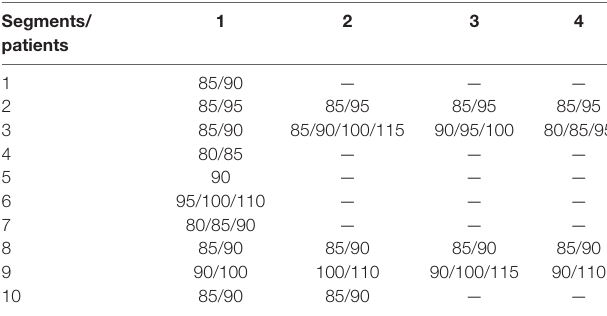
TABLE 3 | The time-frequency power of each patient (units: Hz). Segments/